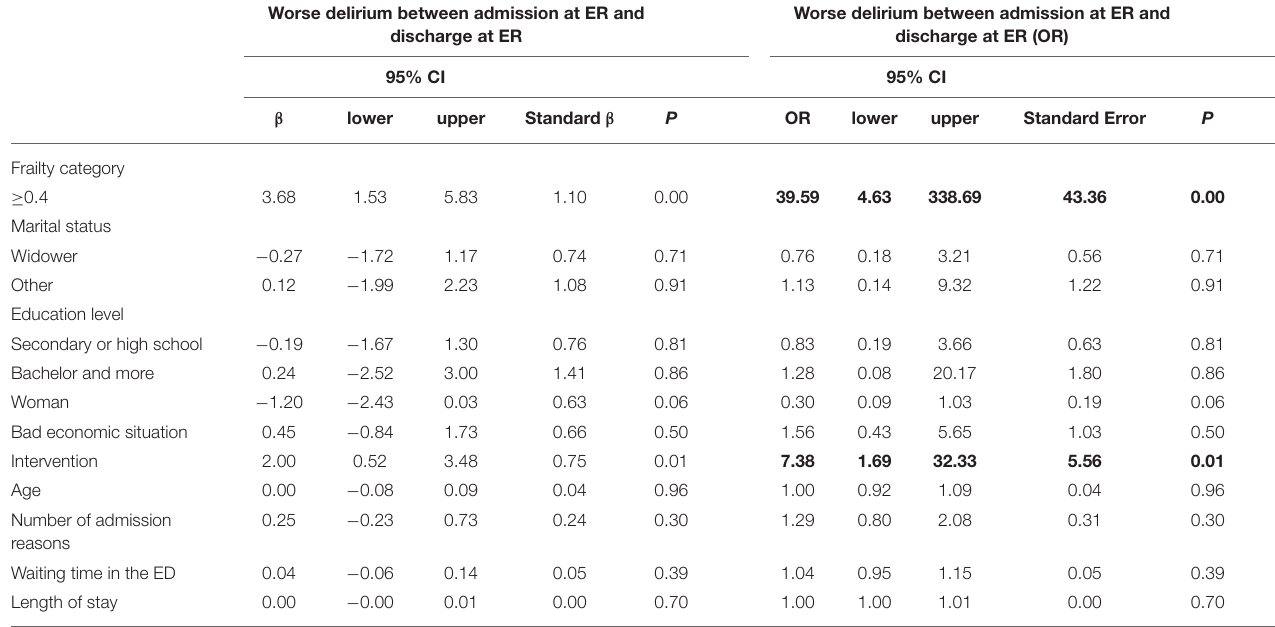
TABLE 3 | Association between delirium with frailty and other variables. Worse delirium between admission at ER and discharge at